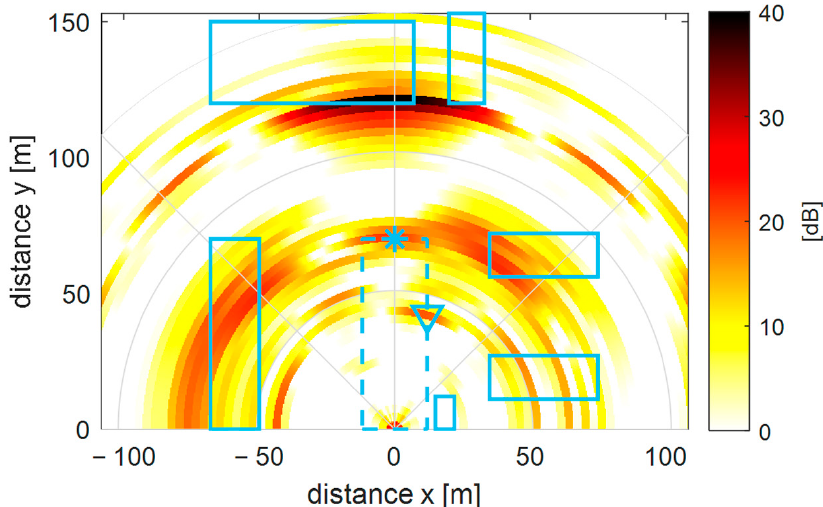
Figure 14. The scene image with calibration.